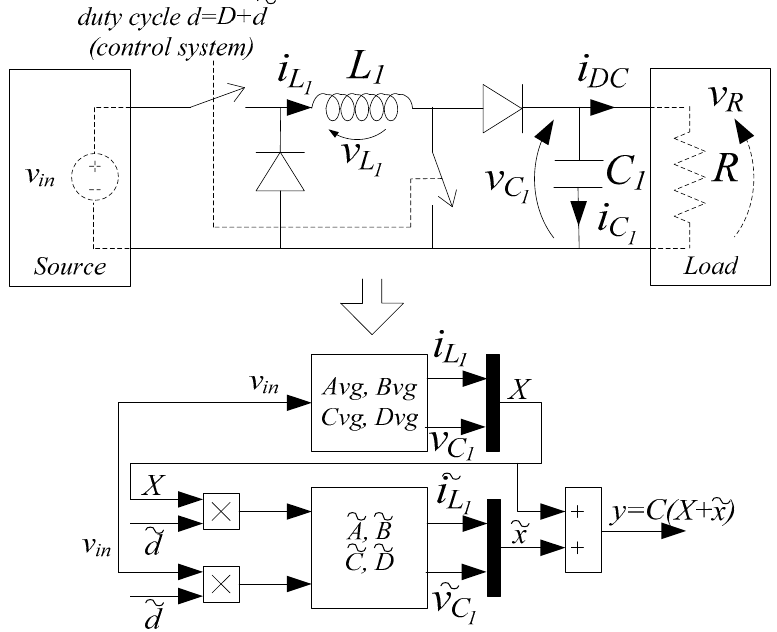
Figure 6. DC-DC converter basic topology and its state-space form including duty cycle variation.